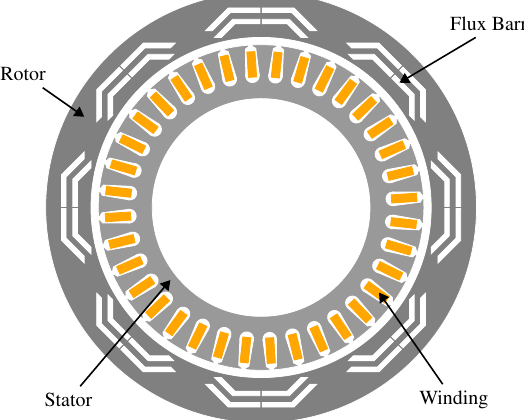
Figure 7. Topology of an outer-rotor synchronous reluctance motor.